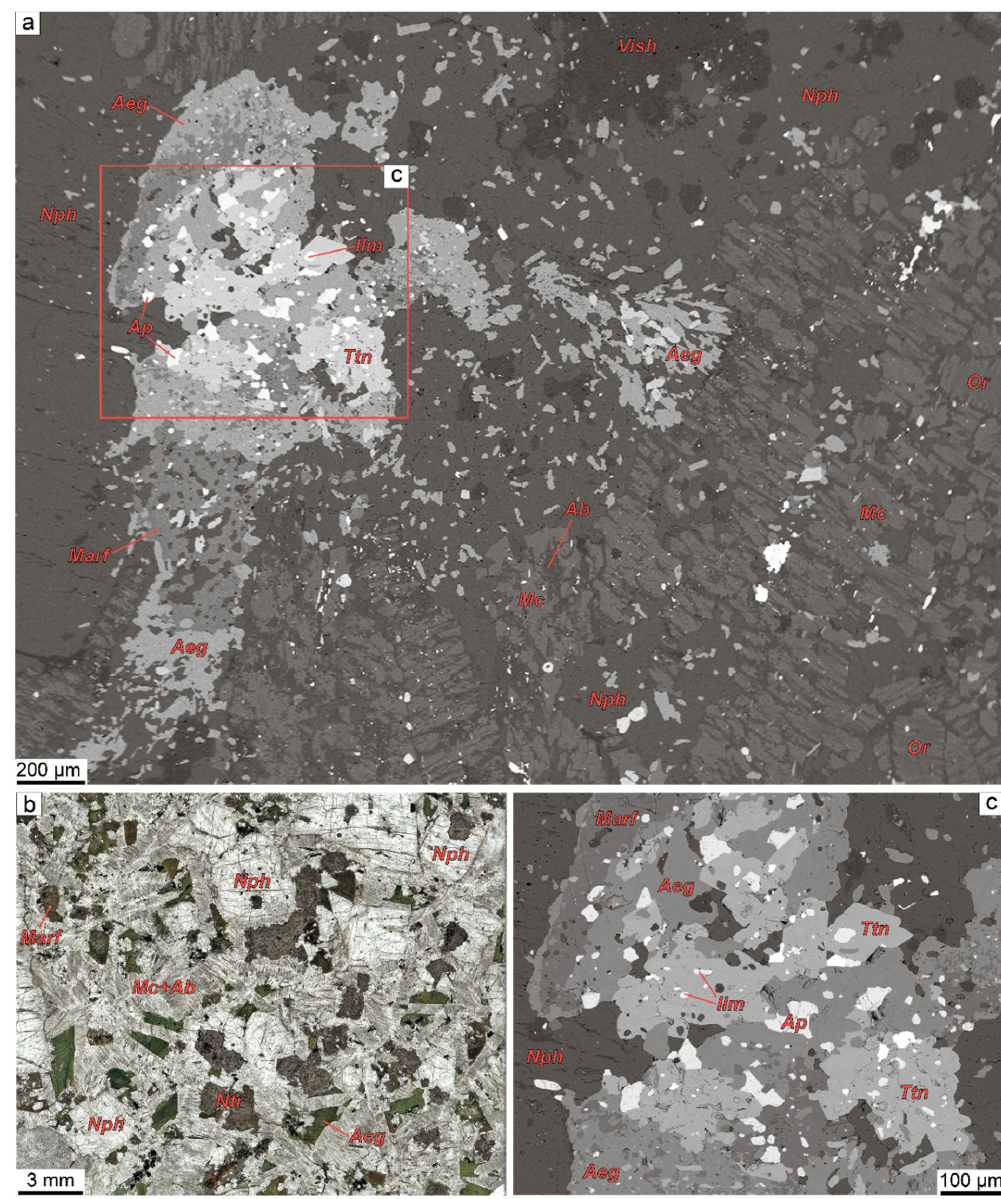
Figure 4. Back-scattered electron (BSE) images ( a , c ) and a photo in transmitted light ( b ) showing the textural relations and mineral paragenesis in uneven-grained nepheline syenite. ( a ) Resorption of microcline by albite and nepheline. Segregation consisting of magnesio-arfvedsonite, aegirine, ilmenite, titanite, and fluorapatite is located among nepheline. On the left, there is a fragment of a large nepheline crystal (Sample LV-156-66). ( b ) Characteristic texture with large euhedral nepheline crystals and resorbed microcline laths (Sample LV-157-54). ( c ) Characteristic association of mafic minerals. Magnesio-arfvedsonite is replaced by aegirine (Sample LV-156-66).